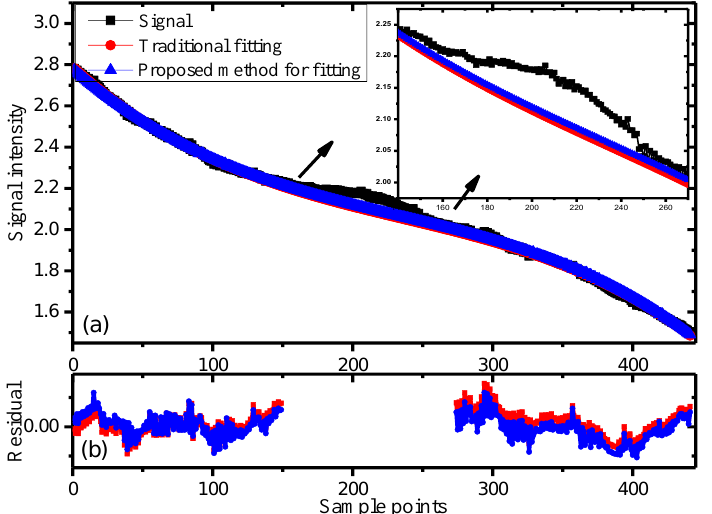
Figure 5. Background signal fitting: ( a ) background signal fitting and ( b ) residual signals in the non-absorbed part.